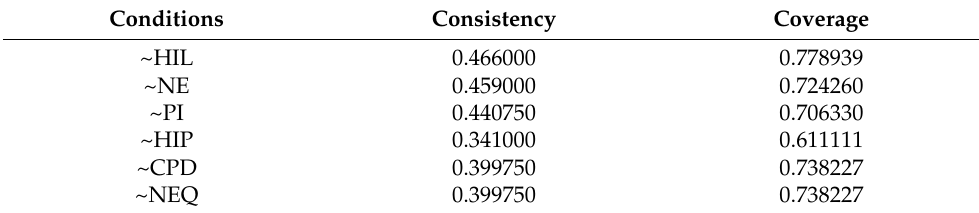
Table 2. The results of the single-factor necessity analysis. Conditions Table 2. Cont.